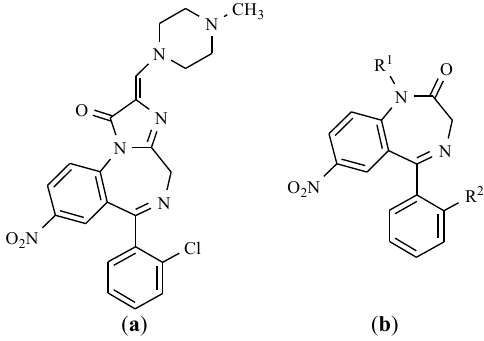
Figure 3. The chemical structure of benzodiazepine derivatives: ( a ) Loprazolam; ( b ) Nitrazepam: R 1 , R 2 = H, Clonazepam: R 1 = H, R 2 = Cl, Flunitrazepam: R 1 = CH 3 , R 2 = F, Nimetazepam: R 1 = CH 3 , R 2 = H.